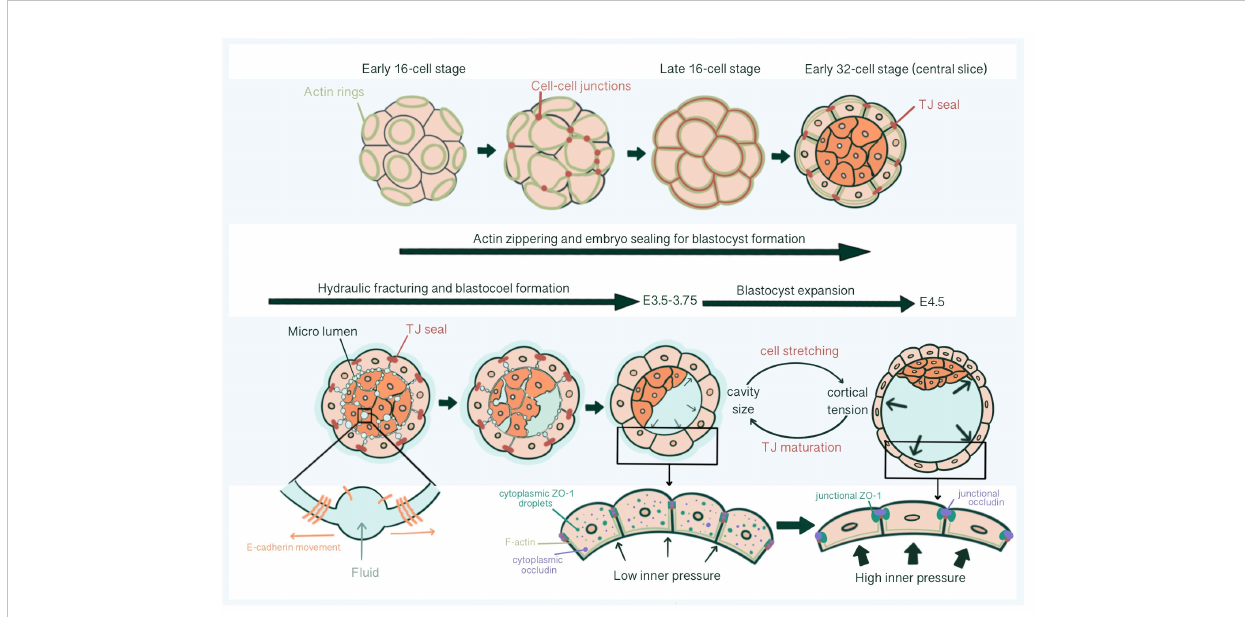
FIGURE 4 Tight junction seal formation and force dependent junctional maturation, enabling hydraulic fracturing and blastocoel expansion, from E2.75 until E4.5. The actin ring structure formed in the apical region of the blastomeres in the early 16-cell stage embryos affects intercellular junction maturation and formation of TJ sealing. With hydraulic fracturing coordinated via reorganization of E-cadherin at cell-cell contacts, fl uid accumulates within the embryo forming the blastocoel The integrity of blastocyst depends on mature TJ seals that prevents collapse with increasing inner pressure. Force dependent (increased luminal pressure and cortical tension, accompanied with TE cell stretching) junctional maturation enables accommodation to pressure increase and blastocoel expansion prior to